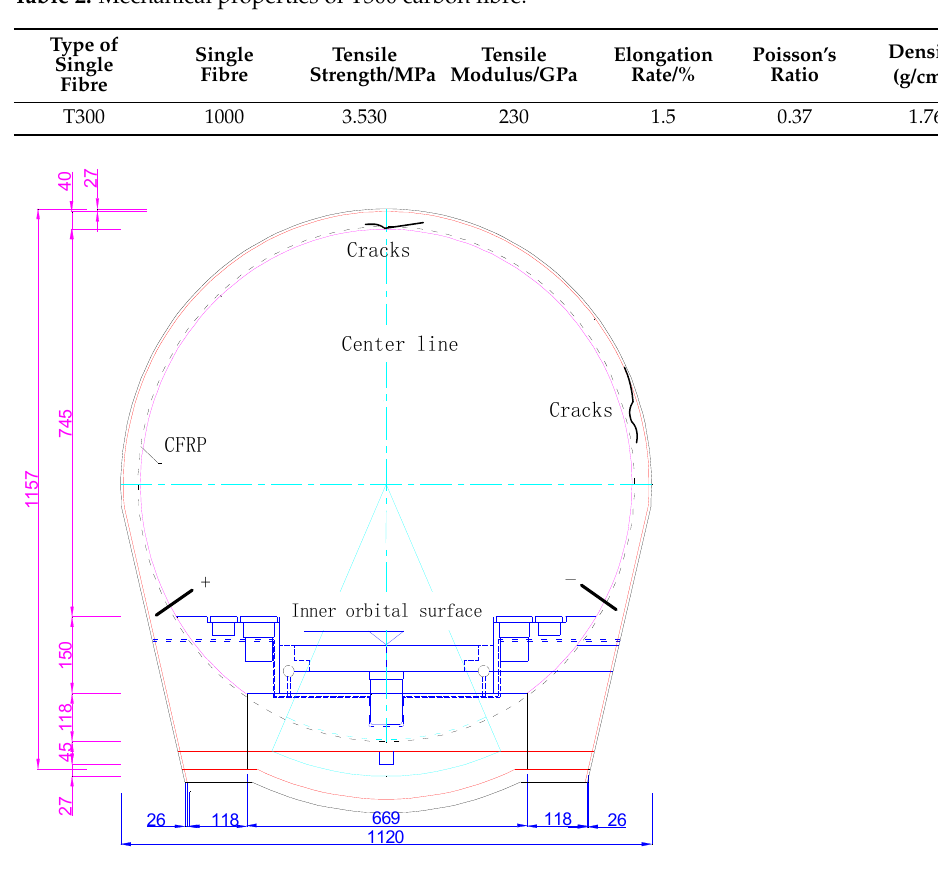
Figure 13. Crack warning method for CFRP reinforced tunnel lining. The pressure of the soil layer around the tunnel is monitored via a pressure box. Pressure boxes are arranged in five measuring positions in the tunnel, including the vault, spandrel and sidewall, to accurately measure and monitor the earth pressure. The vertical and horizontal pressures are represented by the pressures from the tunnel vault and